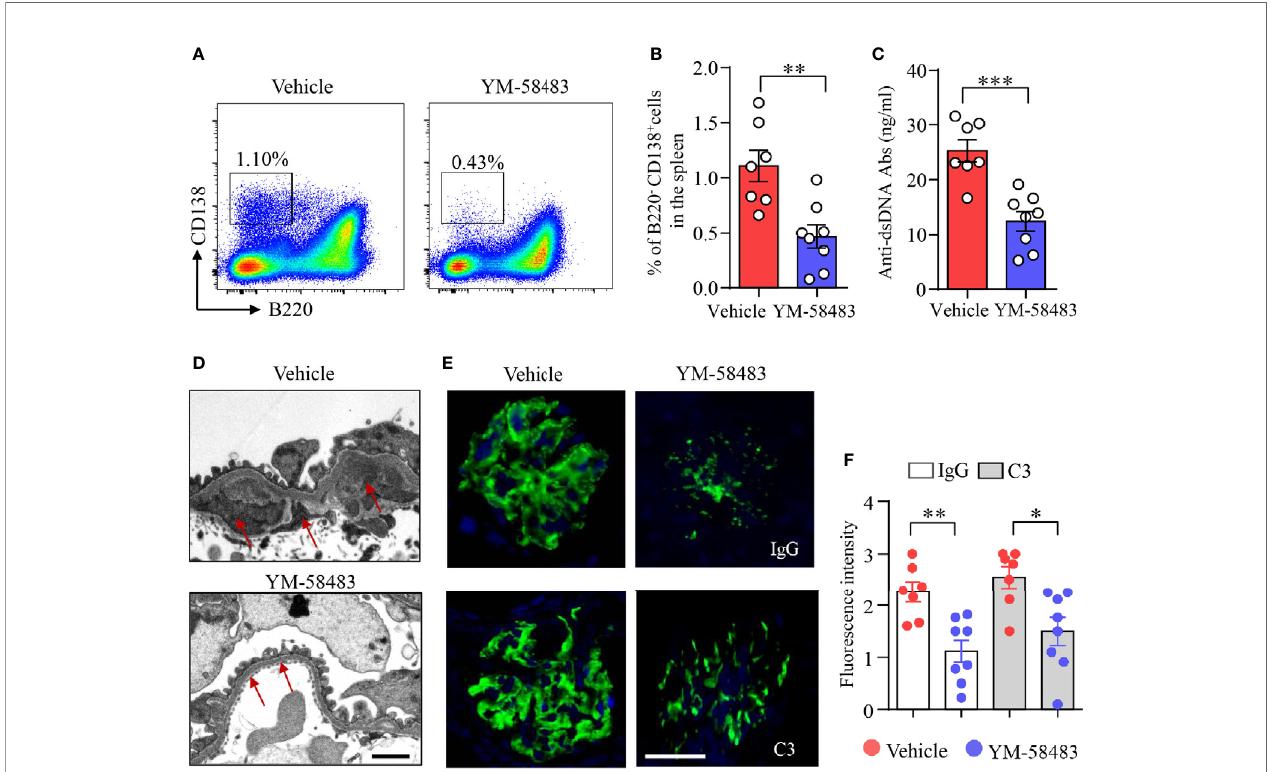
58483 treatment prevented the development of proteinuria ( Figure 6I ) and nephritis in MRL/ lpr mice ( Figures 6J, K